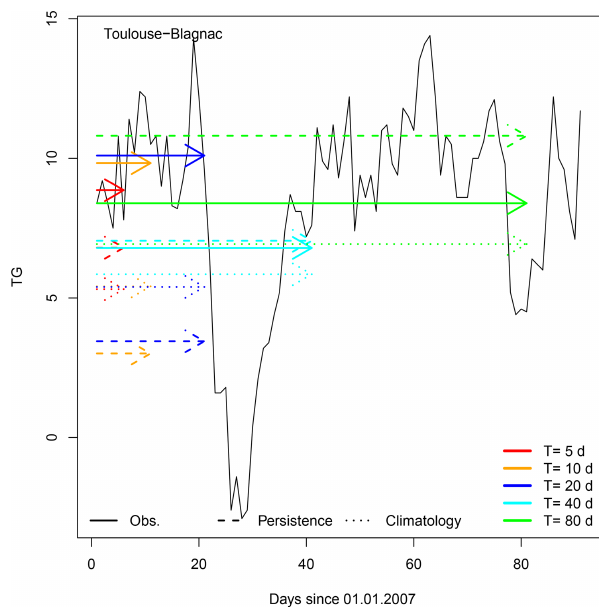
Figure 3. Illustration of average forecast for daily mean temperature (TG) in Toulouse, for 1 January 2007. The continuous black line indicates the observations of TG for the first 90 days of 2007. The colors indicate lead times T . The continuous arrows are for averages of observed TG from 1 January 2007 to the lead time T . The dashed lines are for the persistence forecast of TG and the dotted lines are for the climatology forecast of TG on 1 January